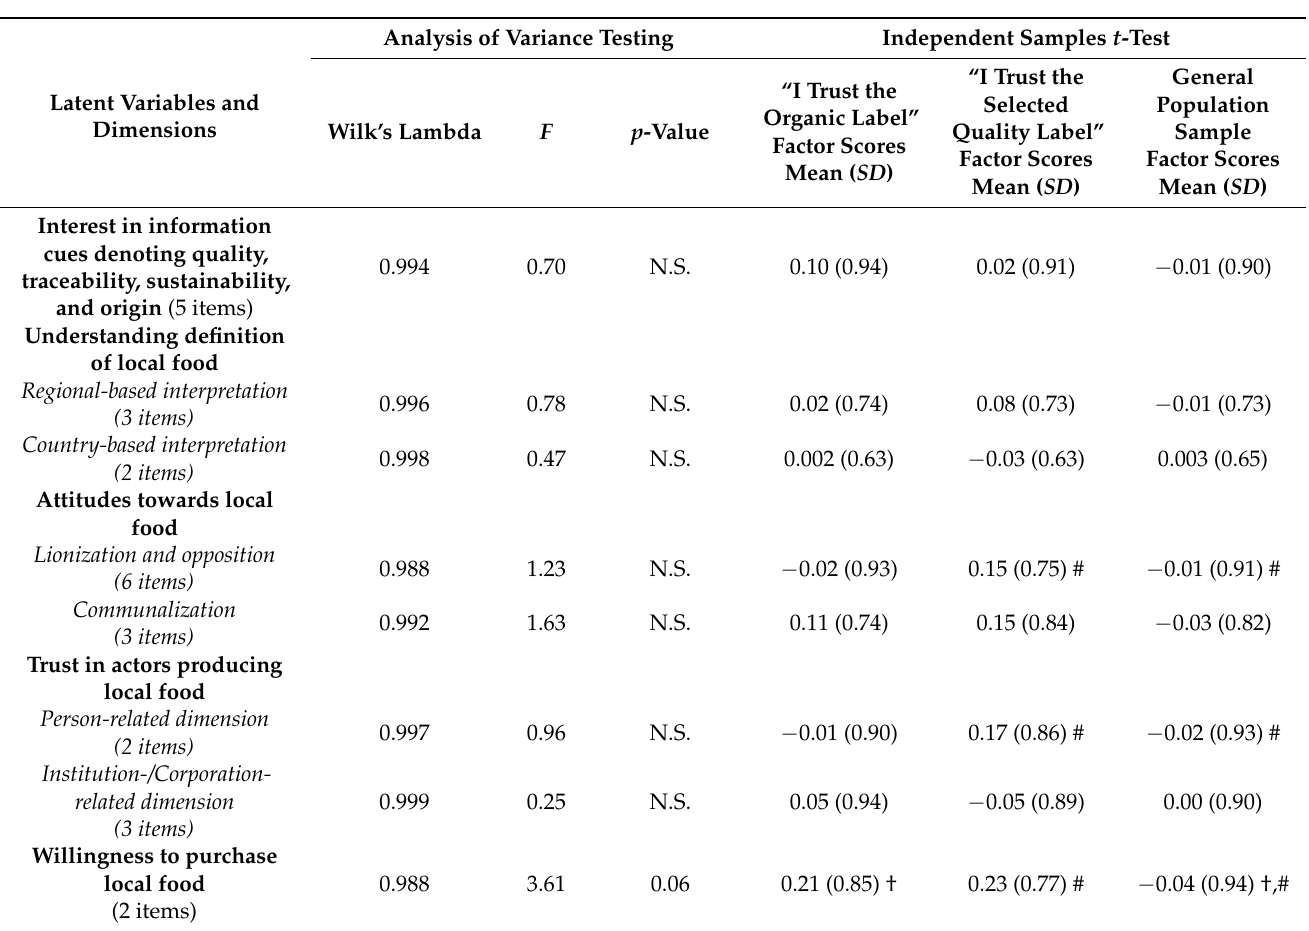
Table 5. Results of the Multivariate Analysis for the Hypothesis Testing of Variance Difference and Mean Comparison